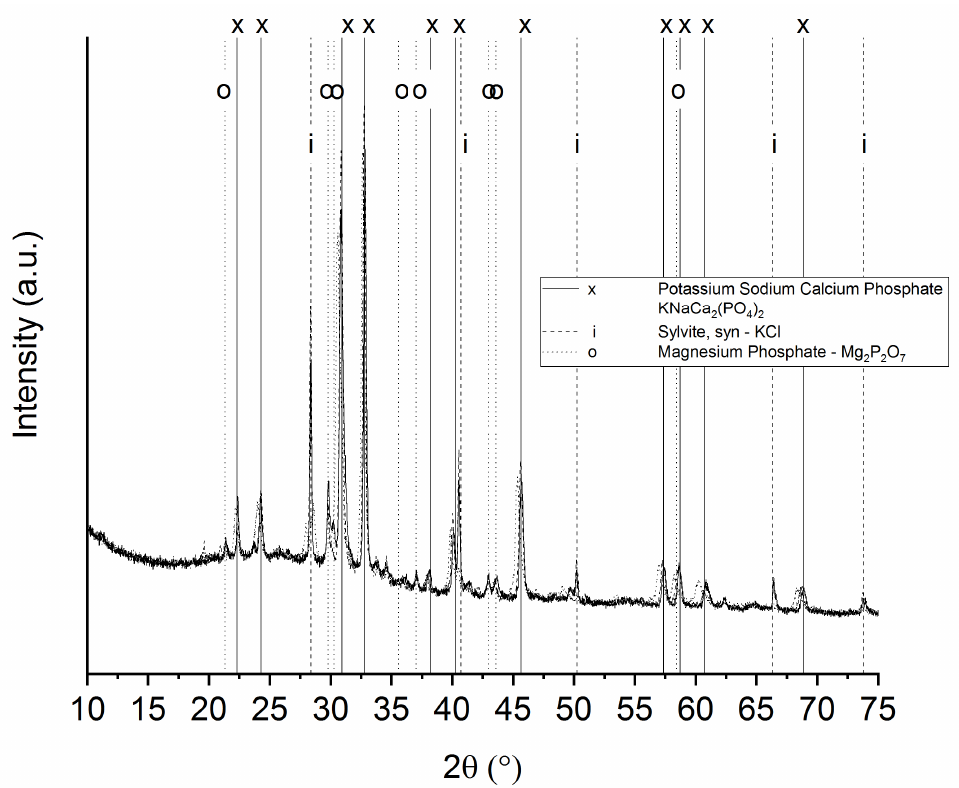
Figure 7. XRD diffractograms of the ashes of carbonized whey scaffolds at 450, 750 and 1000 °C (overlapped). Table 4. Percentage of Calcium and Phosphorus within the SBF.